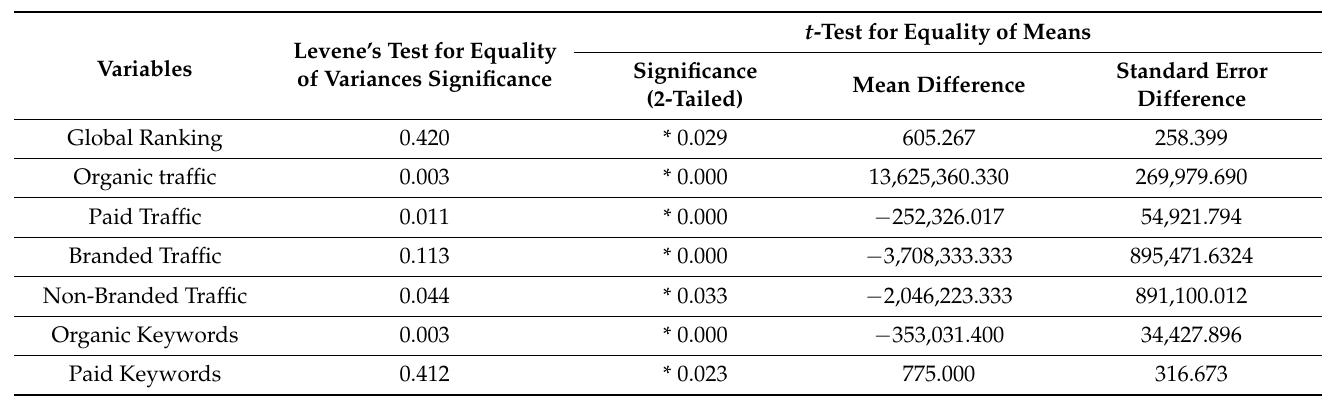
Table 3. Independent sample t -tests results between the pre-COVID and COVID 2nd 12-month period data sets.